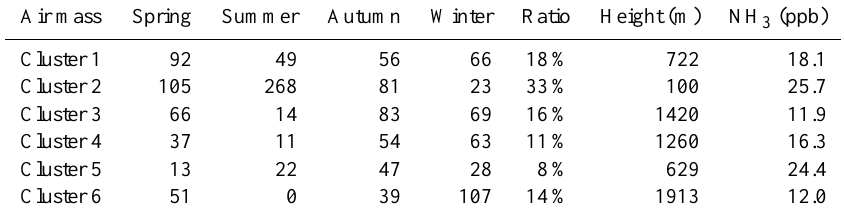
Table 3. Occurrence frequency and mean values of NH 3 for each type of air masses arriving at CMA during July 2009 to June 2010. Air mass